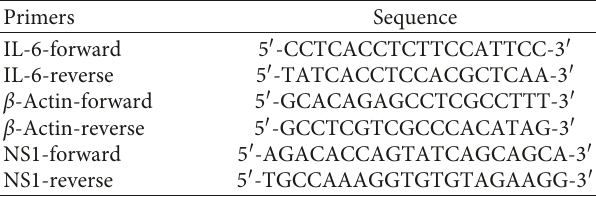
Table 1: Primers used for PCR